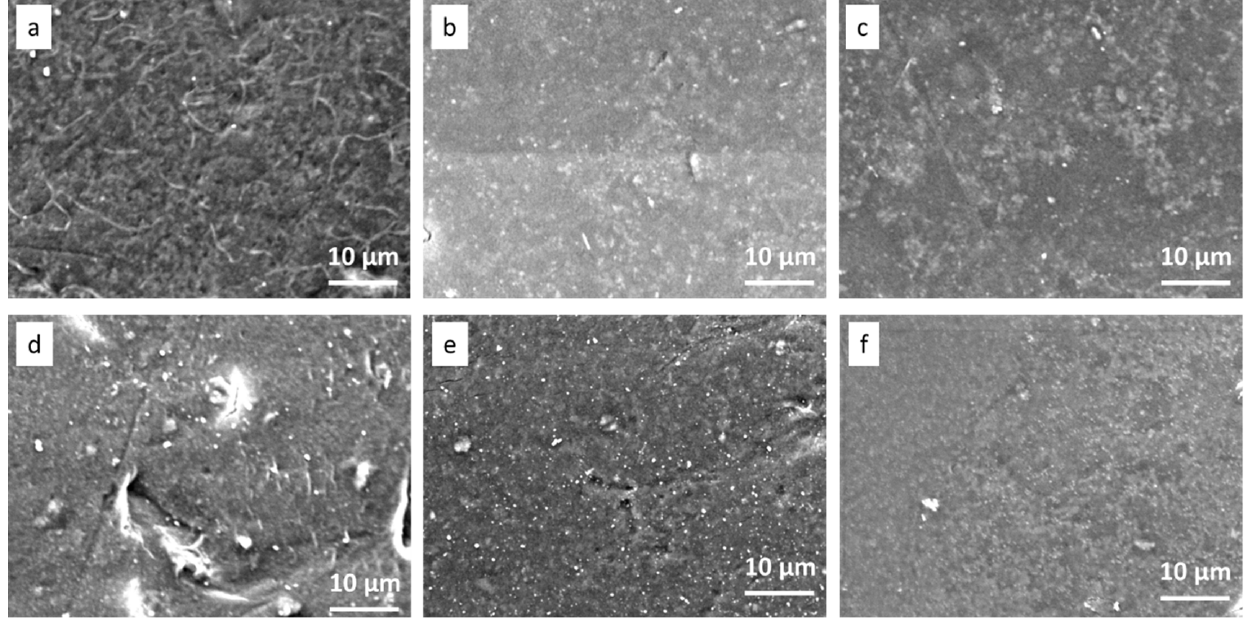
Figure 11. SEM images of ( a ) CEM-3.5, ( b ) CEM-Ag3, ( c ) CEM-Cu3, ( d ) AEM-3.5, ( e ) AEM-Ag3, and ( f ) AEM-Cu3 after batch incubation with E. coli at 37 °C for 24 h.